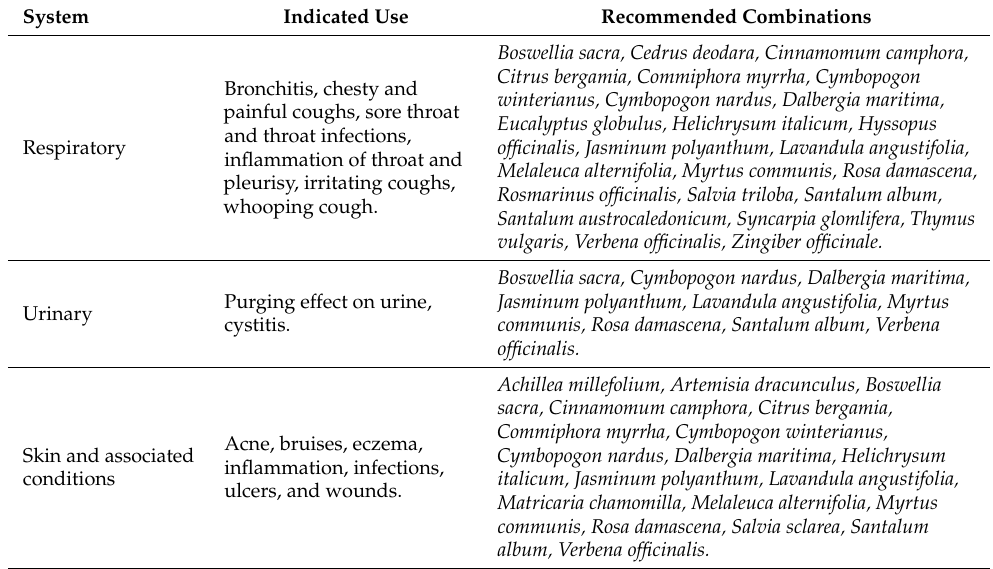
Table 1. Use of V. odorata oil in the aromatherapeutic literature and recommended combinations [12,14–17]. System Indicated